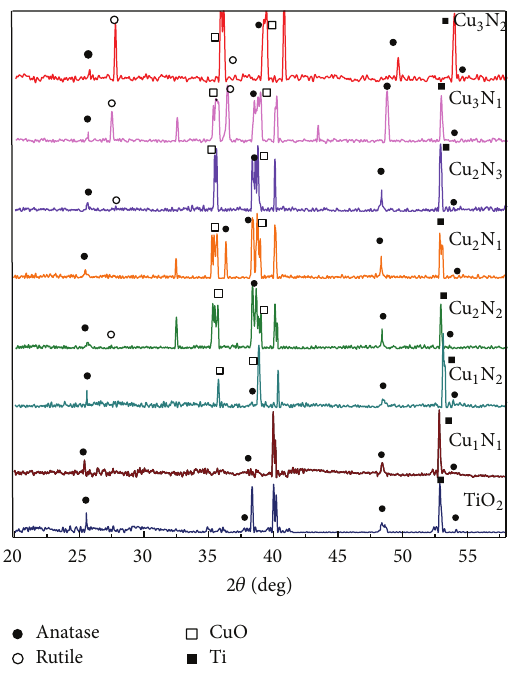
Figure 3: XRD patterns of TiO 2 and Cu/N codoped TiO 2 films with different Cu 2+ / NH 4+ molar ratios and annealed at 500 ∘